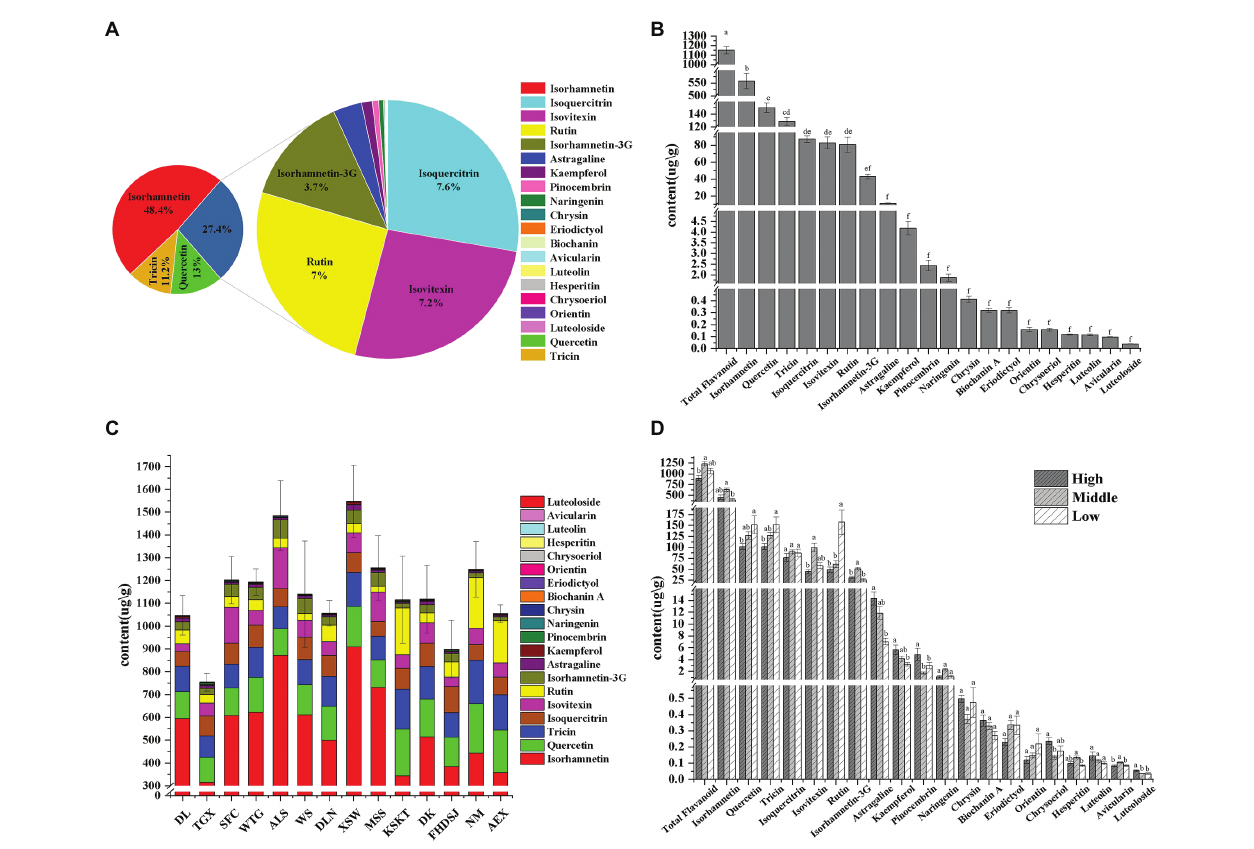
FIGURE 2 | Flavonoid content in A. squarrosum . The composition (A) and content (B) of flavonoids in A. squarrosum . Values are Mean ± SE ( n = 84). (C) The composition and content of flavonoids in 14 A. squarrosum populations. Values are Mean ± SE ( n = 6). (D) The composition and content of flavonoids in different altitude populations. Values are Mean ± SE ( n = 12, 54, 18). Values marked with the different or same letters indicate statistically significant and not significant differences, respectively, using Tukey honest significant difference (HSD) test at the 5% significance